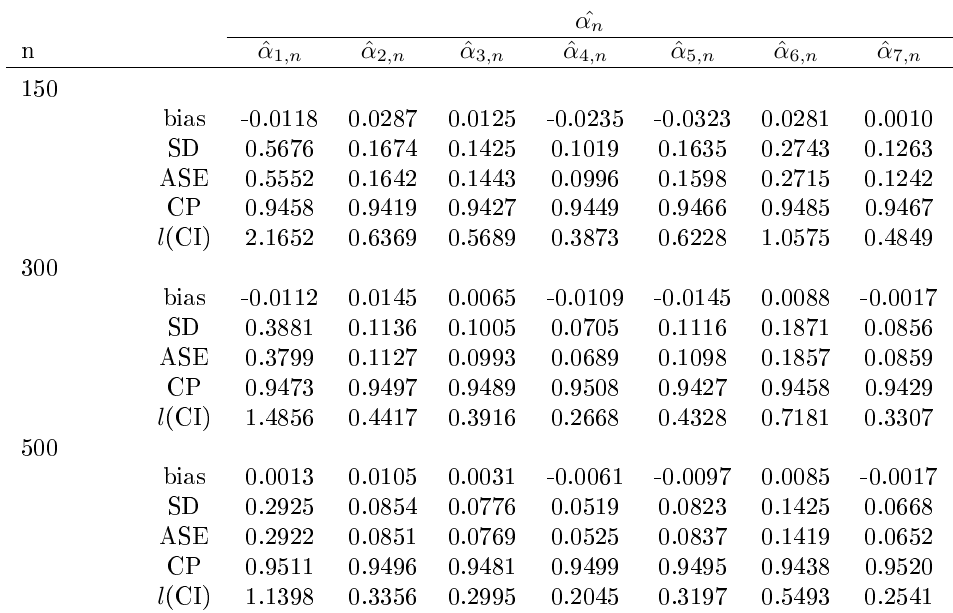
Tab. 1: The results by performing Newton-Raphson